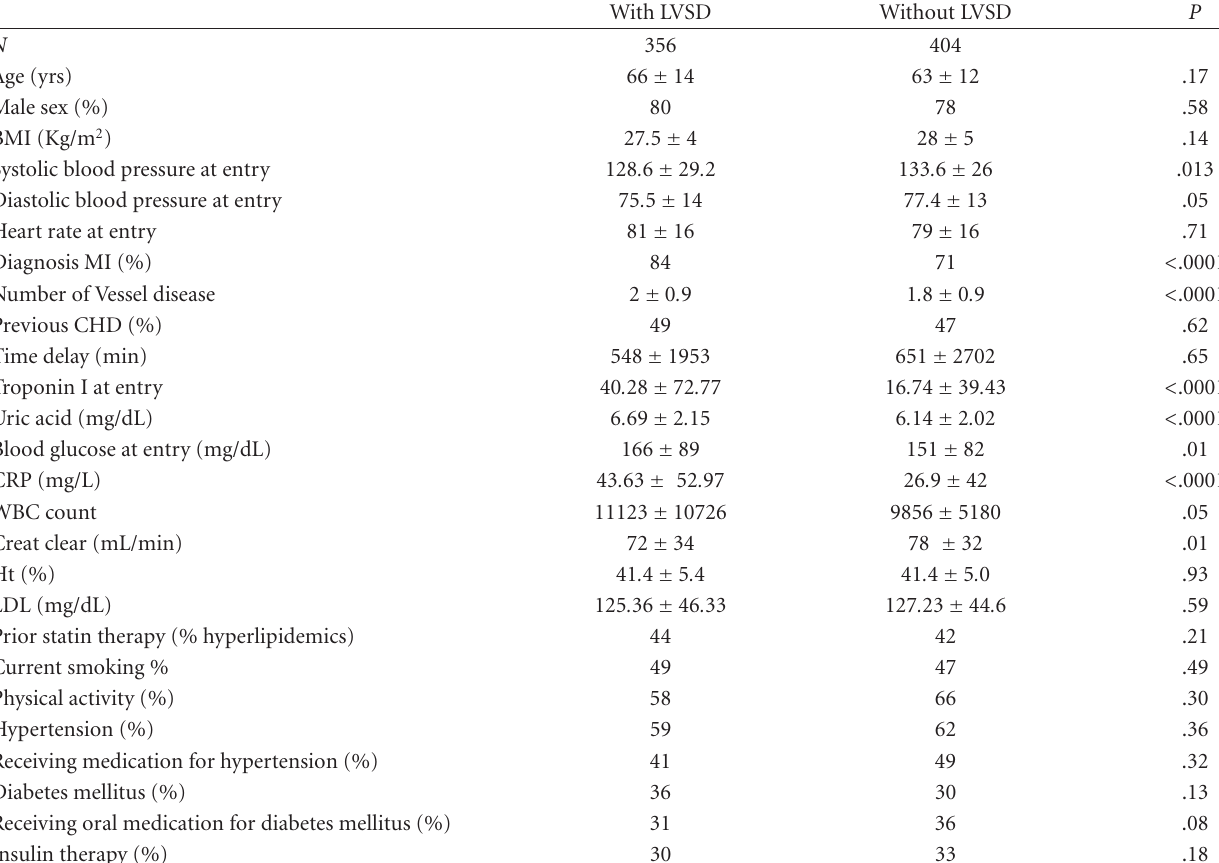
Table 1: Clinical characteristics of the patients according to systolic heart